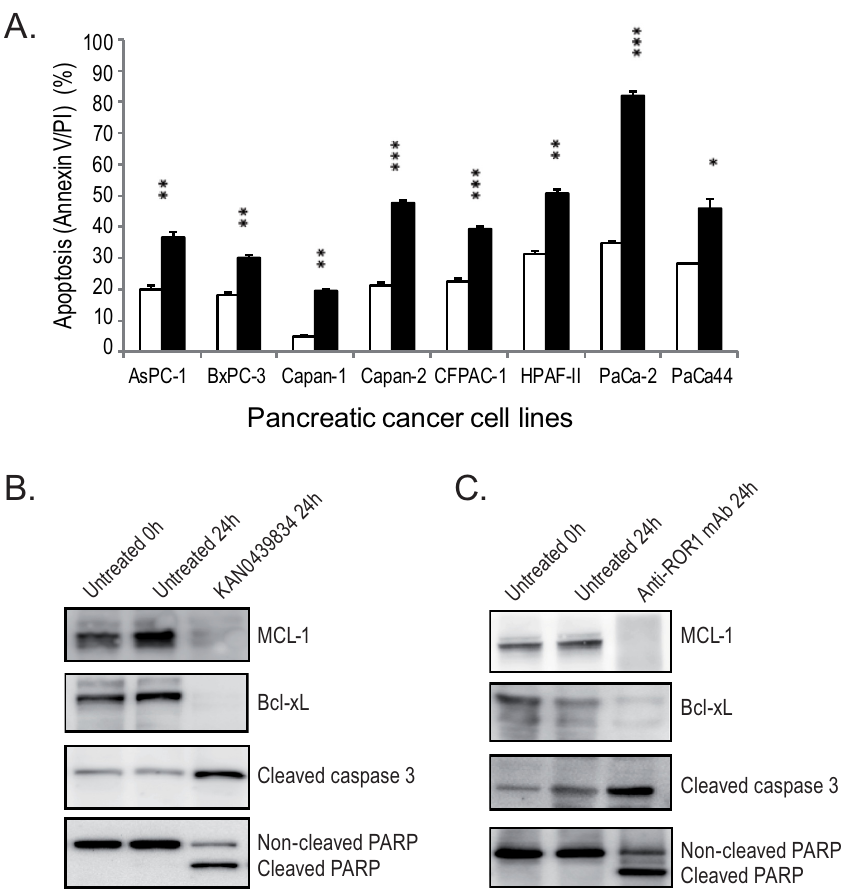
Fig 2. (A) Apoptosis/(Annexin V/PI) (mean ± SEM) of KAN0439834 (500 nM) ( & ) and anti-ROR1 mAb (10 μ g/ml) ( & ) in pancreatic cancer cells after 72 h of incubation. P-values refer to the comparison between anti-ROR1 mAb and KAN0439834 incubated cells. (cid:3) p = 0.05; (cid:3)(cid:3) p = 0.01; (cid:3)(cid:3)(cid:3) p = 0.001 and ns = not significant. Effects of KAN0439834 (B) and anti-ROR1 mAb (C) on the apoptosis associated proteins MCL-1, Bcl-xL, caspase-3 and PARP proteins after 24